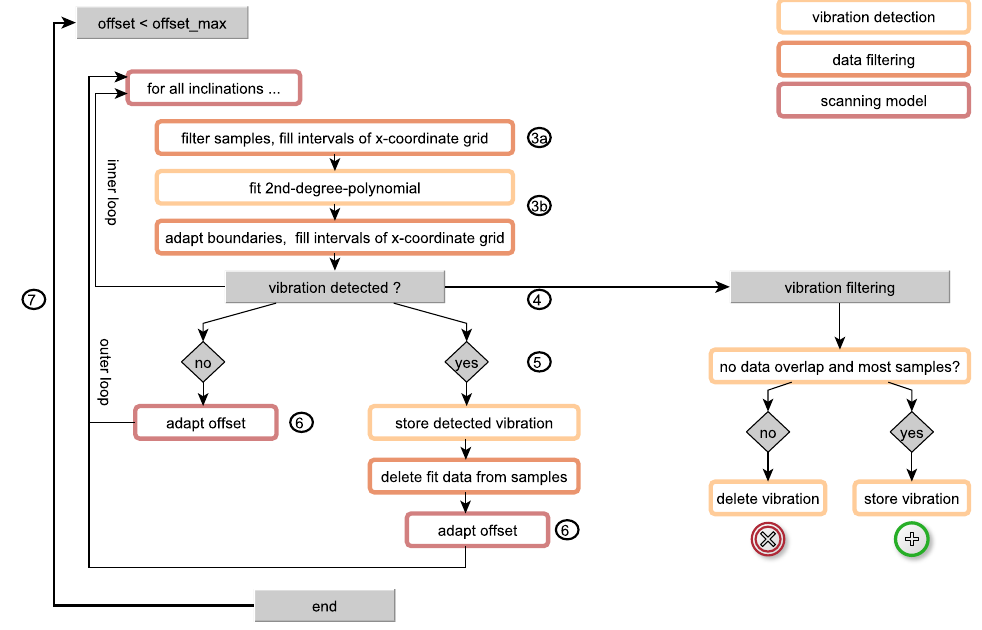
Figure 8. Visualisation of vibration scanning and vibration filtering for detecting Type 2